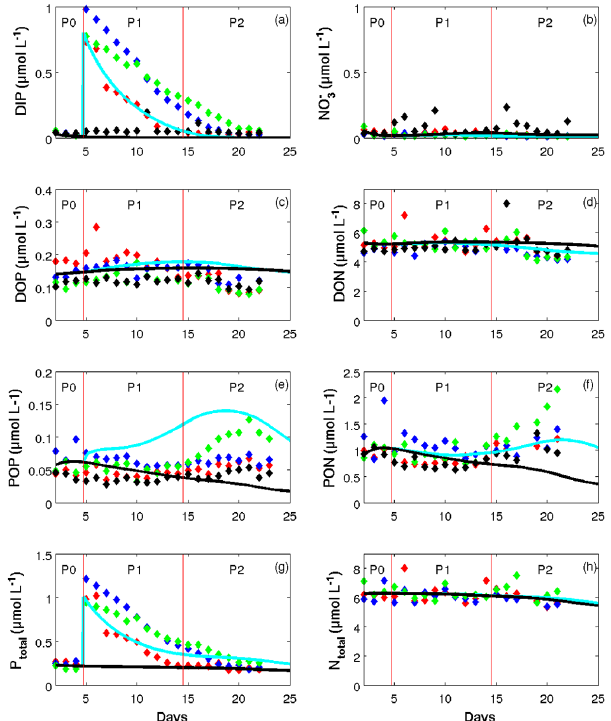
Figure 3. Patterns of change over time in (a) dissolved inorganic phosphate (DIP), (b) nitrate (NO − ), (c) dissolved organic phos- 3 phate (DOP), (d) dissolved organic nitrogen (DON), (e) particulate organic phosphorus (POP), (f) particulate organic nitrogen (PON), (g) total phosphorus (P total ) and (h) total nitrogen (N total ) concen- trations (µmolL − 1 ) in model outputs (solid lines: SIM E – blue; SIM C – black) averaged over depth superimposed on data obser- vations averaged over depth in the three mesocosms (M1 – red; M2 – blue; M3 – green) and in surrounding waters (black). Red vertical lines distinguish the three periods P0 (before the DIP en- richment), P1 (diatom–diazotroph associations dominate the dia- zotrophic community) and P2 (unicellular N 2 -fixing cyanobacteria (Group C) dominate the diazotrophic